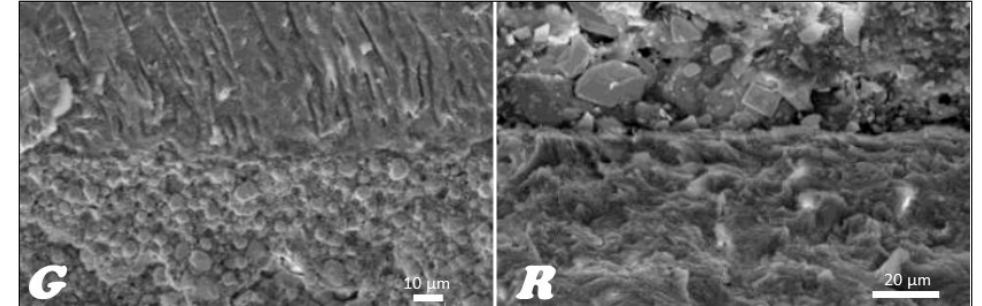
Figure 22. The borderline of the root canal wall, a thin intermediate layer of sealant and THC thermoplastically placed filling material: ( G ) gutta-percha-based filling material with a visible cross-section of dentinal tubules along their transverse to the axis of the root canal; ( R ) resilon with visible flake structure in the sealant interlayer; SEM.